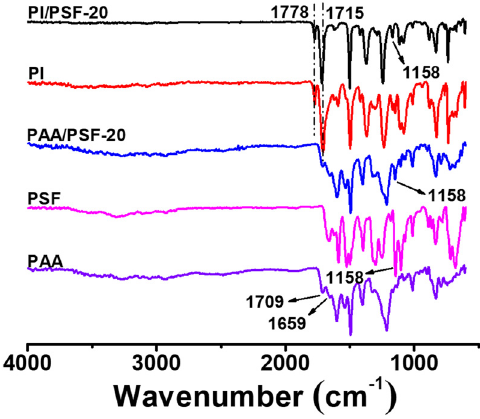
Figure 2: FT - IR spectra of pure PAA, PSF, PAA/PSF - 20 and PI/PSF - 20 fi